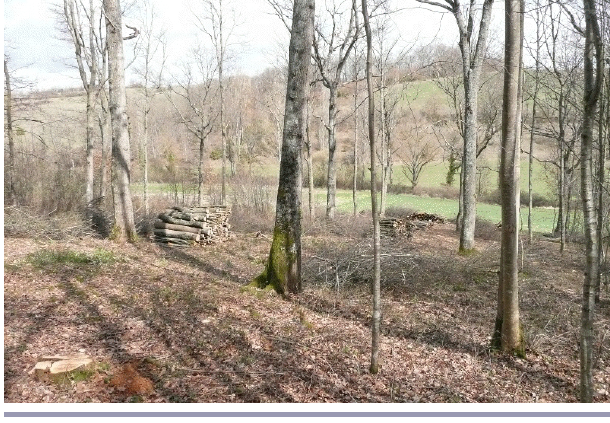
Fig. 2. Understory with cut of coppice for firewood and with reserved oak